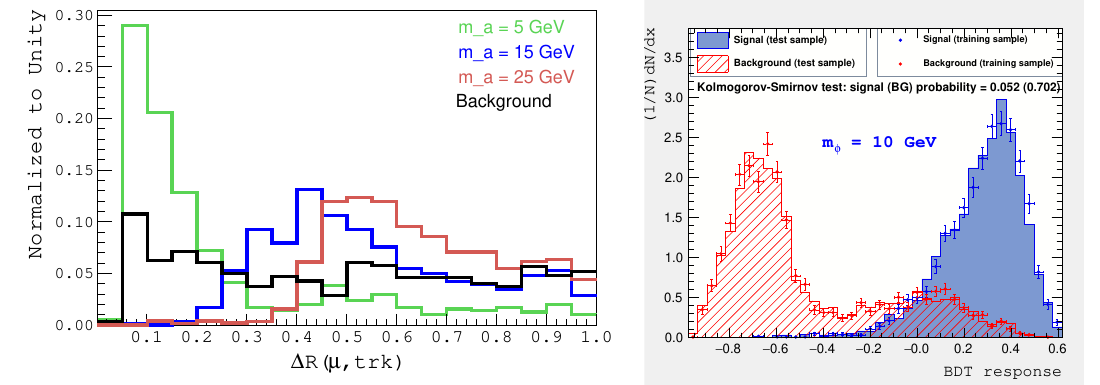
Figure 2 . Angular separation between muon and a single charge track for different values of m φ . The black histogram shows the background distribution. Evidently the separation is small for light φ and increases as m φ increases. Right Panel: here we show BDT response of signal and background for m φ = 10